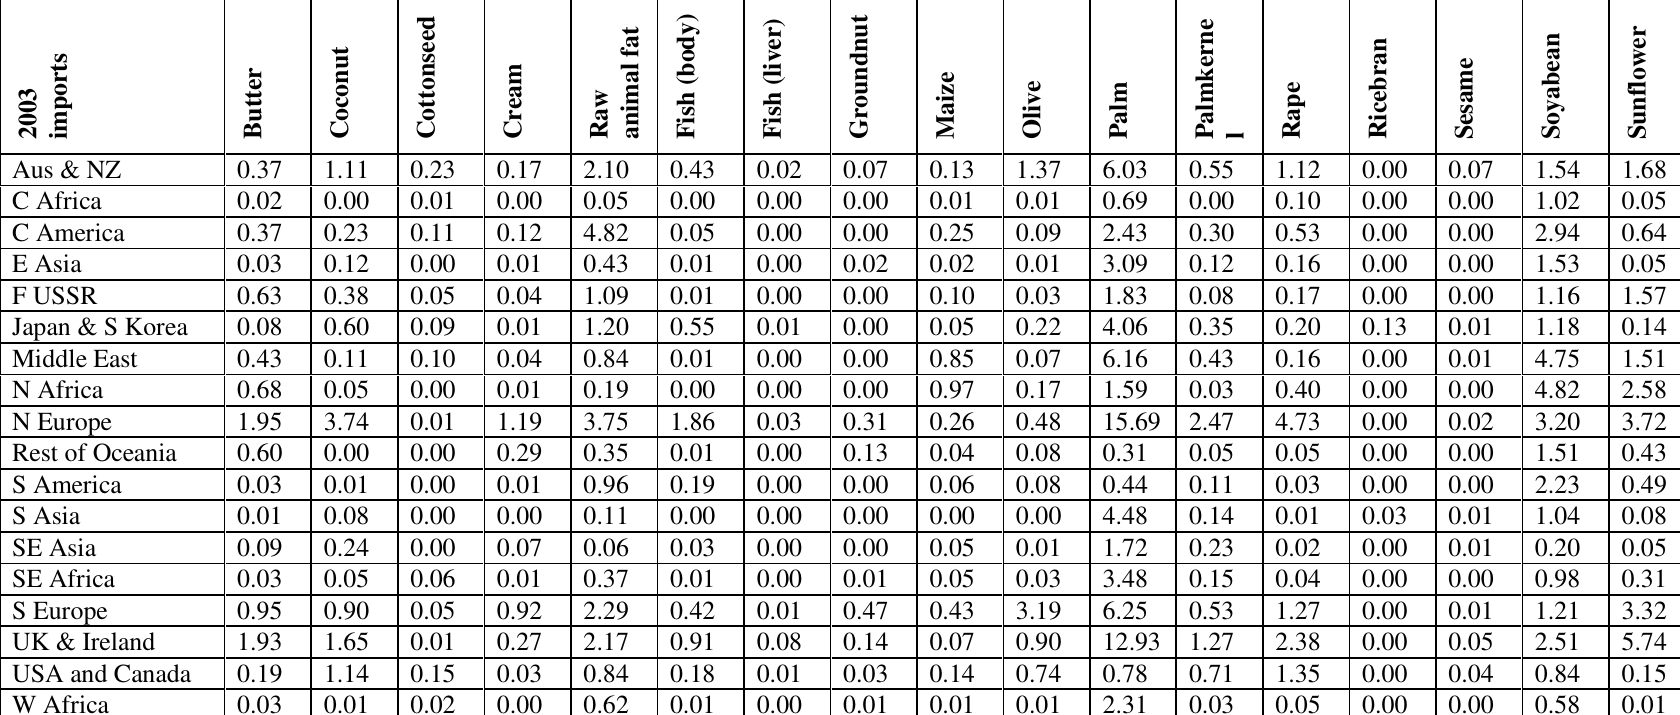
Table 4: World lipid imports, Kg/capita/year, 2003 (Source: FAOSTAT data, 2006).